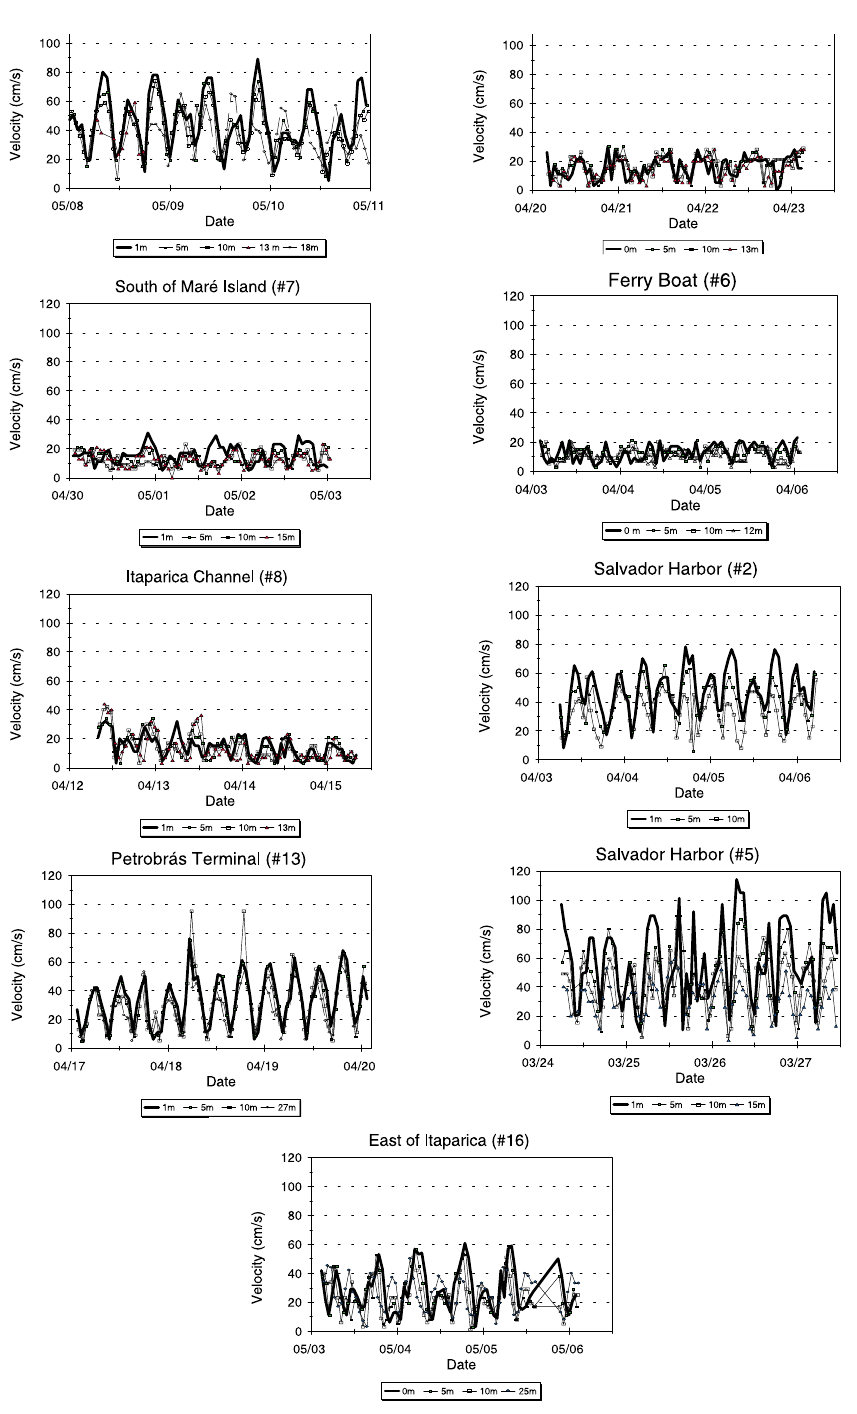
Fig. 7 – Tidal currents inside the TSB (see Figure 6 for an assessment of the tidal range during the time of